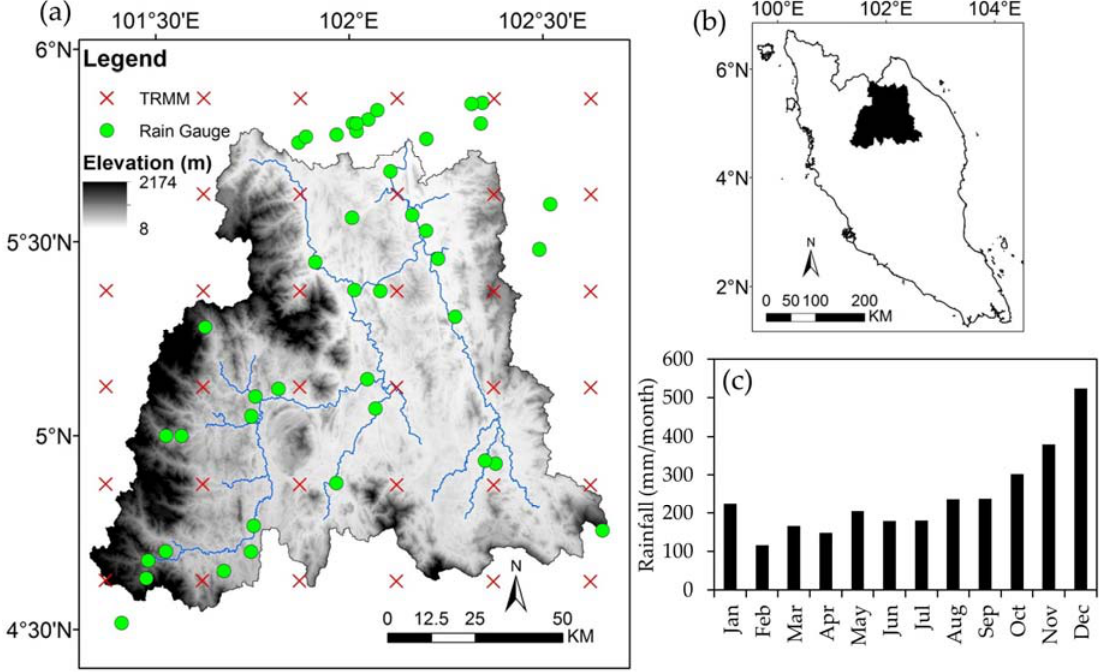
Figure 1. ( a ) Kelantan River Basin, ( b ) Peninsular Malaysia and ( c ) monthly mean precipitation from 1998 to 2014.